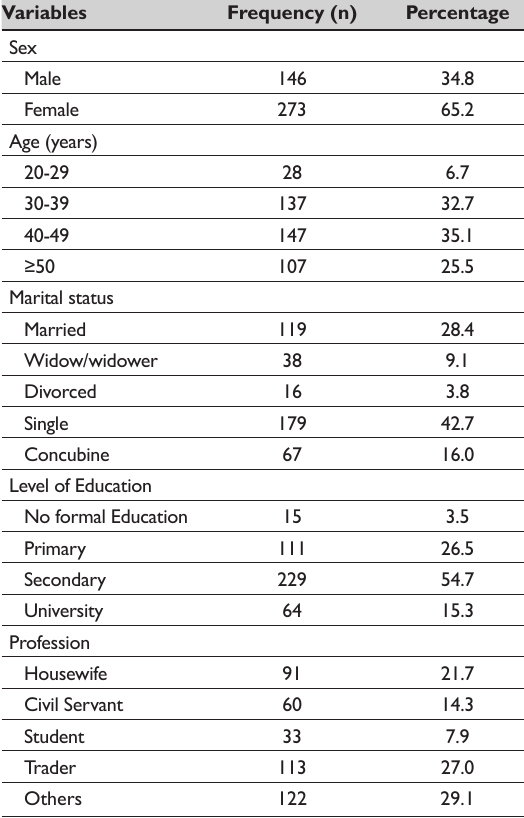
Table 5: Sociodemographic characteristics of patients with opportunistic